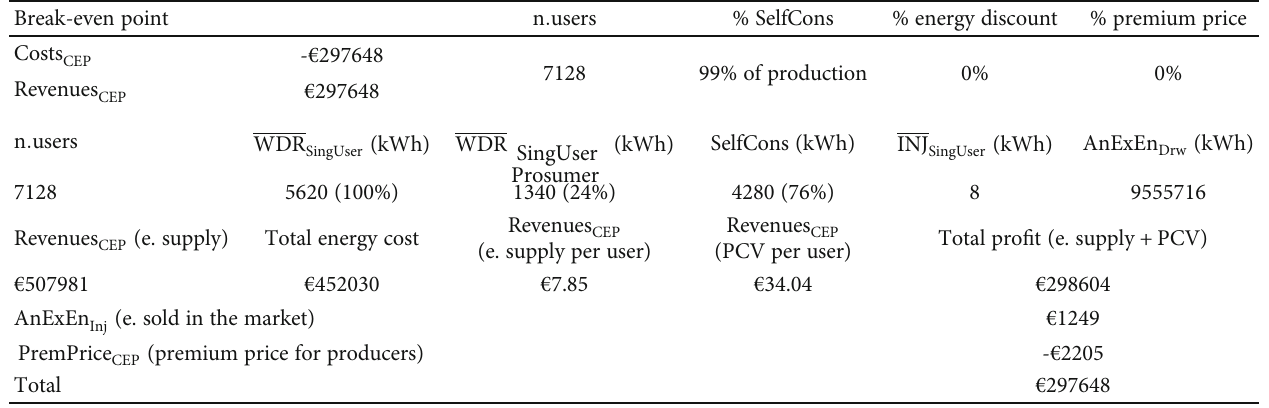
Table 13: Cost revenues and users ’ distribution — 2017 (b).